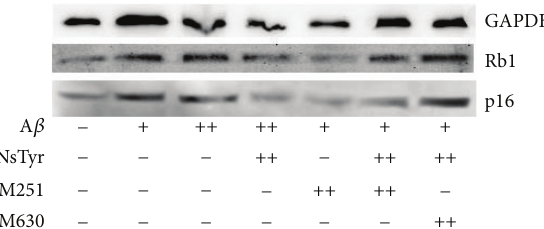
Figure 11: The influence of selective receptor antagonist on the expression of Rb1 and p16 in NSPCs. The NSPCs were treated with , (3) 1 𝜇 M A 𝛽 1 , (4) A 𝛽 1 + NsTyr- (1) none, (2) 0.3 𝜇 M A 𝛽 1 – 42 – 42 – 42 + AM251, (6) A 𝛽 1 + NsTyr-2K + AM251, and (7) 2K, (5) A 𝛽 1 – 42 – 42 + NsTyr-2K + AM630. The expression of Rb1 and p16 was A 𝛽 1 – 42 detected by